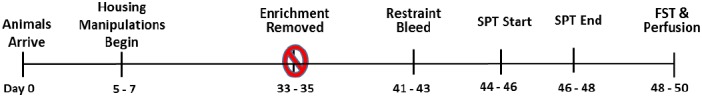
Experimental time-line.